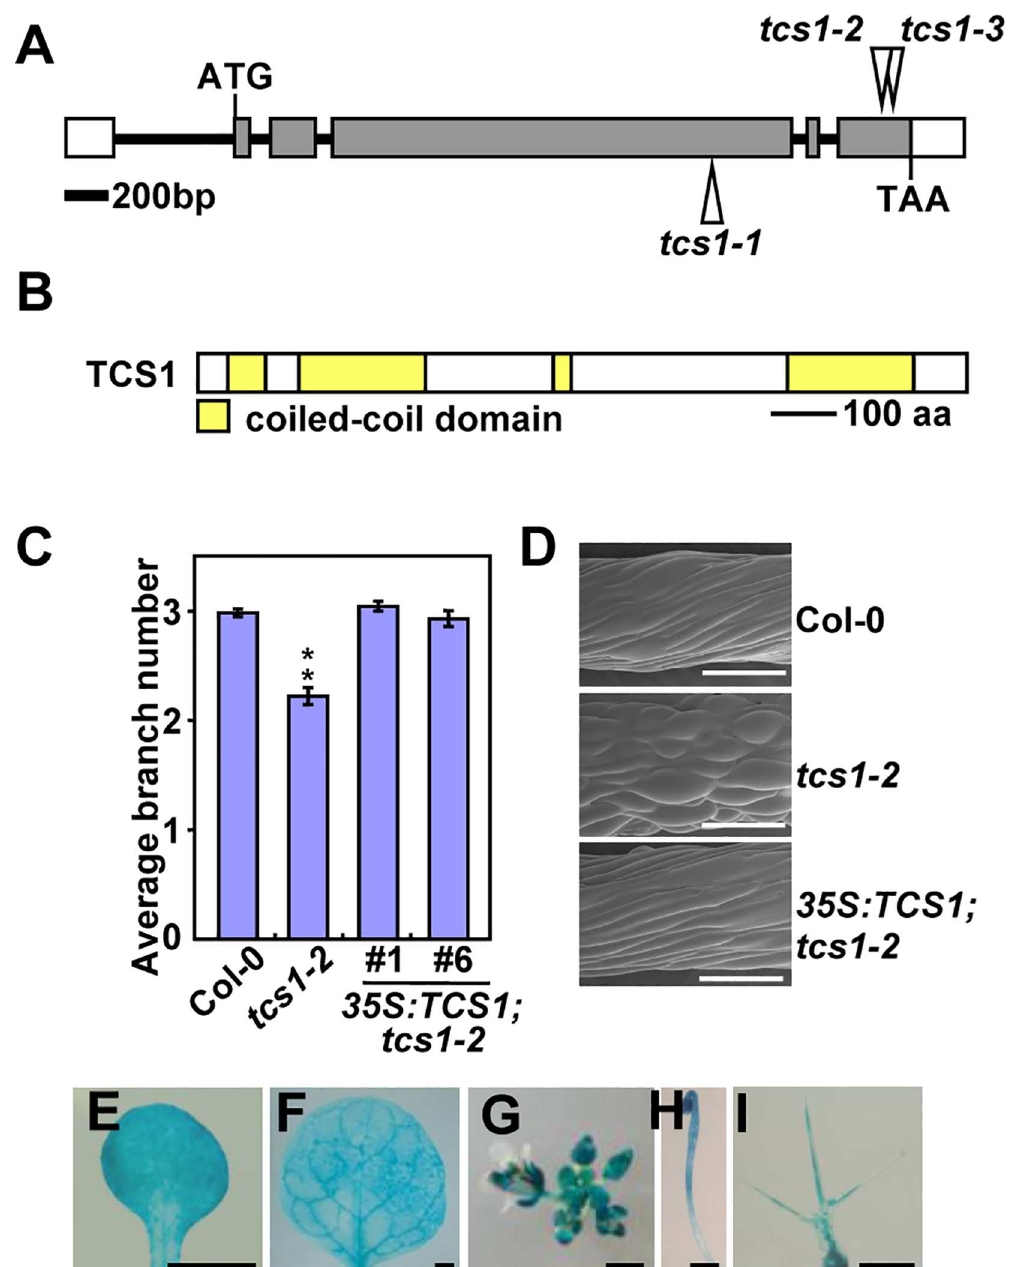
Fig 4. Identification of the TCS1 gene. (A) The TCS1 gene structure. The start codon (ATG) and the stop codon (TAA) are indicated.Closed boxes indicate the coding sequences, open boxes show the 5’ and 3’ untranslated regions, and the line between boxes indicatesthe intron. The T-DNA insertion sites ( tcs1-1 , tcs1-2 and tcs1-3 ) in TCS1 are shown. (B) The predicted TCS1 protein contains four coiled-coildomains. aa, amino acids. (C) The average number of trichome branches in Col-0, tcs1-2 , 35S : TCS1;tcs1-2#1 and 35S : TCS1 ; tcs1-2#6 leaves. Values are given as mean ± SE. ** P < 0.01 comparedwith Col-0 (Student’s t test). (D) Scanning electron microscope images of epidermal cells in Col-0, tcs1-2 and 35S : TCS1;tcs1-2 hypocotyls grown in ½ MS containing 0.3 μ M oryzalin for 15 days in dark. Bars = 200 μ m. (E-I) TCS1 expressionactivity was monitored by pTCS1 : GUS transgene expression. Histochemical analysis of GUS activity in a cotyledon (E), a leaf (F), an inflorescence (G), a 4-day-olddark-grownseedling(H) and a trichome (I). Bars = 1 mm in (E-H) and 0.1 mm in